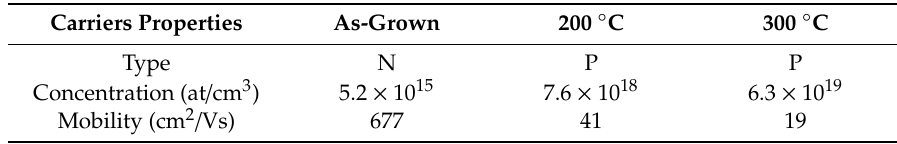
Table 1. Carriers type, concentration and mobility extracted from Hall e ff ect measurements before and after annealing of the p + epi-Si layers.